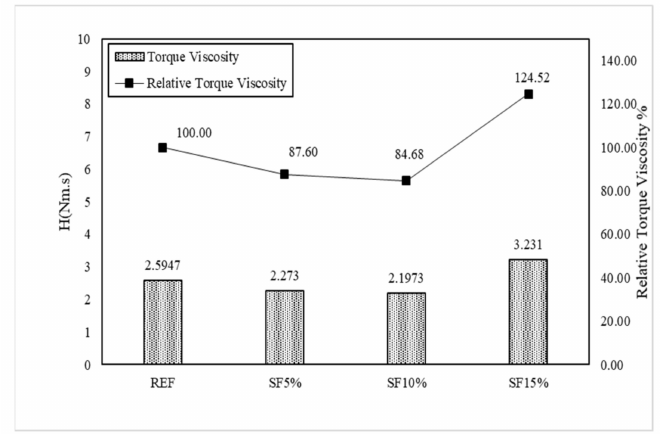
Figure 17. Torque viscosity (H) of the mixing ratio (Jeon’s data).